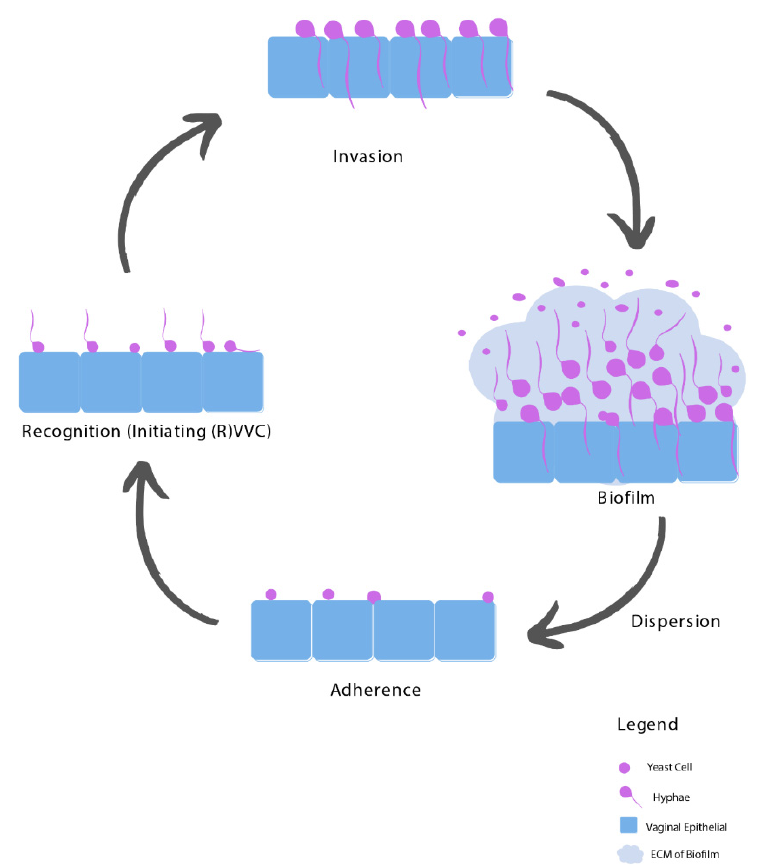
Figure 1. Biofilm formation of Candida species during the pathogenesis of (R)VVC. Yeast cells adhere to the vaginal epithelium and subsequently form hyphae, which together with secretion of Candidalysin determine recognition by the immune system and drive damage and vulvovaginal immunopathogenesis. Invasion of the Candida follows through hyphal extension, relying on both the strain and host factors. Next, biofilms can start to form, from which Candida cells can be released (dispersion) as planktonic cells and reinitiate the complete process.